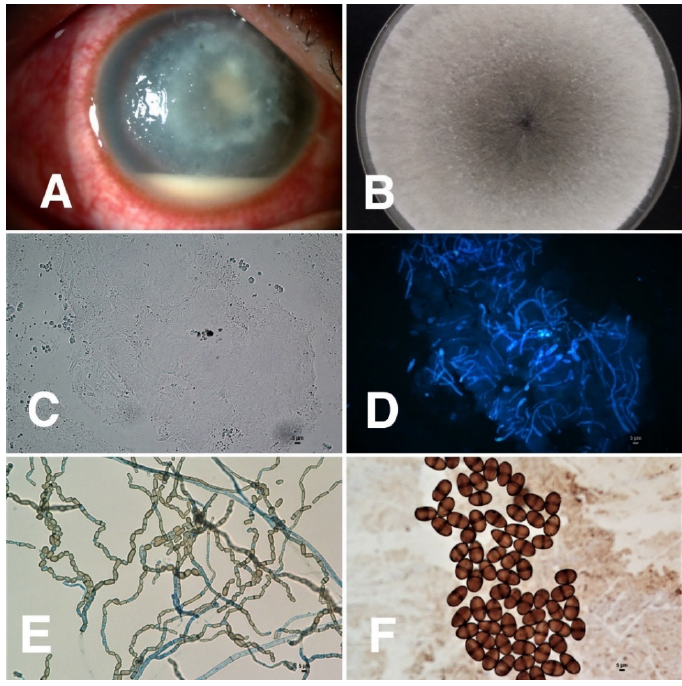
Figure 3. Clinical characteristics of Lasiodiplodia keratitis and microbiological identification from cor- neal scraping specimens. ( A ) Lasiodiplodia keratitis showing a feathery edge, hypopyon, and macro- scopic pigmentation; ( B ) cultivation on Sabouraud’s dextrose agar at 28 °C for 3 and 7 days shows white fluffy colony that becomes jet black when aged; ( C ) 10% KOH mount showing fungal hyphae, magnification 400; ( D ) fluorescent microscopic picture was taken after calcofluor white staining, magnification 400; ( E , F ) microscopic examination of the slide culture shows brown septate hyphae at 400 magnification and two-celled arthroconidia at 1000 magnification.